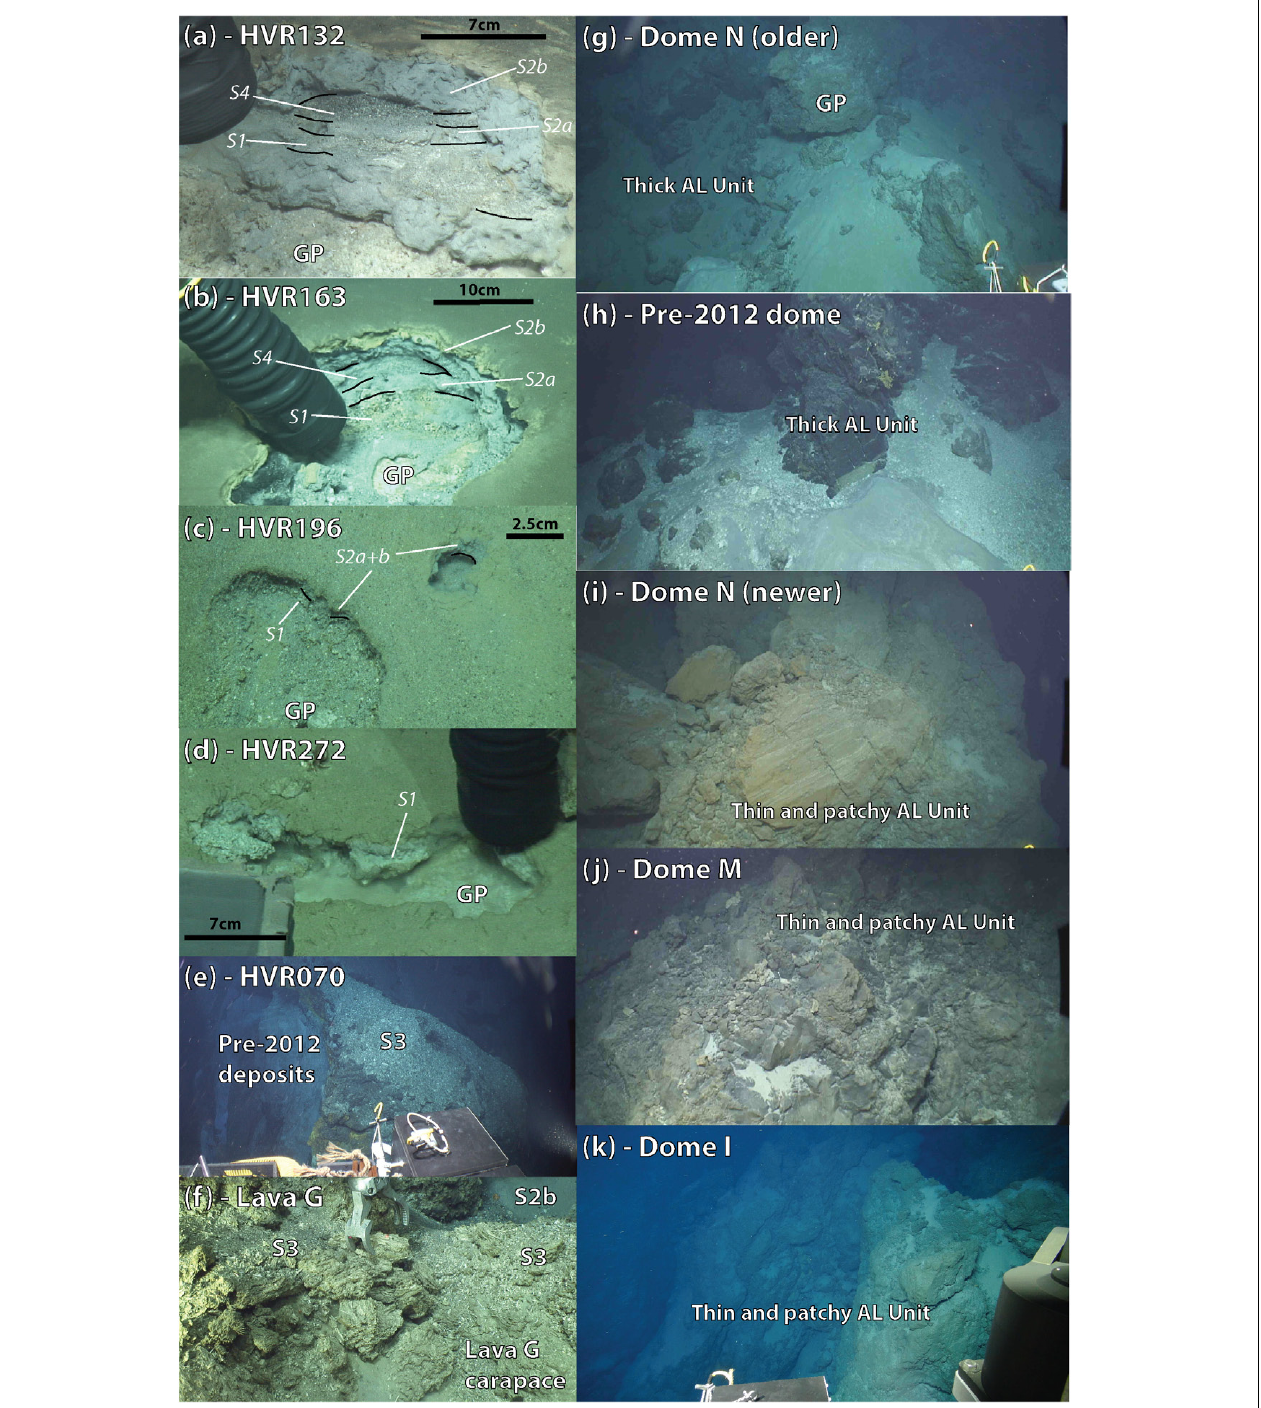
FIGURE 2 | Seafloor images of AL unit layering exposed during sampling from atop GPs at locations HVR132 (a) , HVR163 (b) , HVR196 (c) , and HVR272 (d) . At both HVR132 (a) and HVR163 (b) a similar stratigraphy can be observed showing four layers with comparable layer thicknesses, apparent grainsize, and color. At HVR196 (c) only two layers can be seen. At HVR272 (c) only a single layer can be seen ( e and f ) show a clastic deposit consisting of lapilli and ash with dominantly elongate tube morphologies at HVR070 (e) and overlying the carapace of Lava G (f) . In (g–k) , the variation in the AL unit coverage overlying lavas around the caldera is shown. Thick deposits of the AL unit can be seen overlying an apparently older part of Lava N (g) and also overlying a lava produced prior to the 2012 Havre eruption (h) . Over the more-recent part of Dome N (i) , and on Domes M (j) , and I (k) , the AL unit is thinner and patchier. Domes with similar shapes were chosen to provide a consistent context for observed variations in the AL